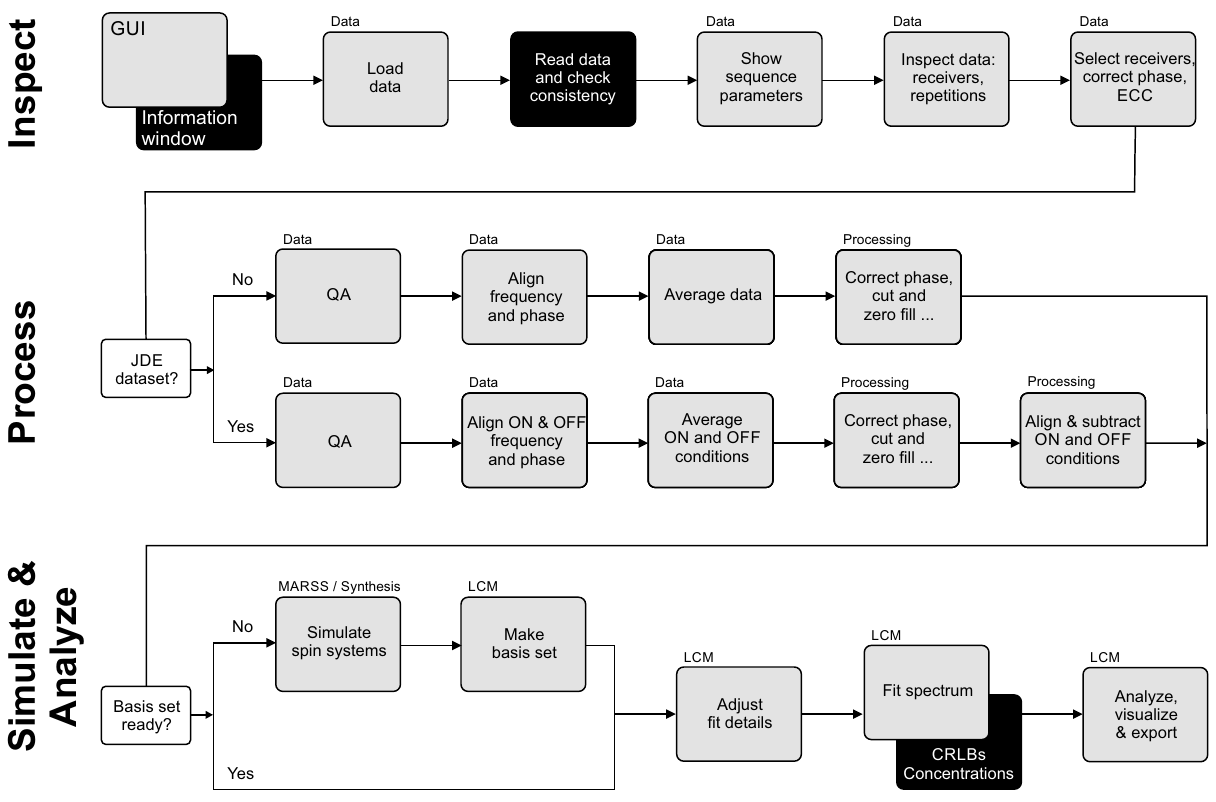
Figure 2. Typical processing pipeline in INSPECTOR for brain MRS. All steps are completely GUI based and no scripting or interfacing is required. Gray rectangles represent tabs on the GUI with page names in the upper left. Black rectangles represent the information window in steps when it is advised to pay attention to text output. CRLB Cramér–Rao lower bound, ECC eddy-current correction, LCM linear combination modeling, JDE J -difference editing, MARSS Magnetic Resonance Spectrum Simulator, QA quality